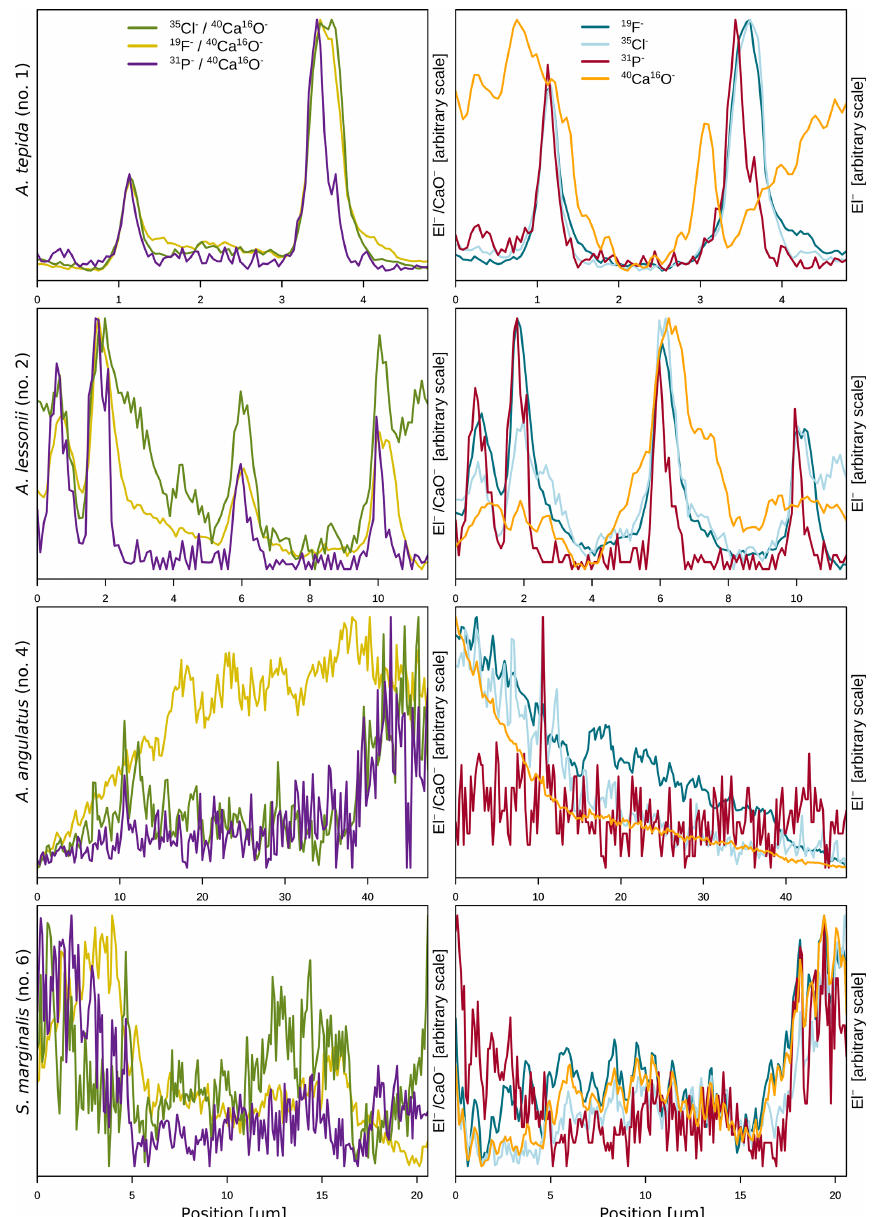
Figure A6. Illustration to show that the banding pattern seen in the lateral profiles of the rotaliid species in Fig. 1 is not caused by lower Ca ion counts at the position of organic linings. The left panels show the same lateral profiles of the El / Ca ion count ratios as shown in Fig. 1, whereas the right panels show the distribution of the individual elements (shown as ion counts) along the same lateral